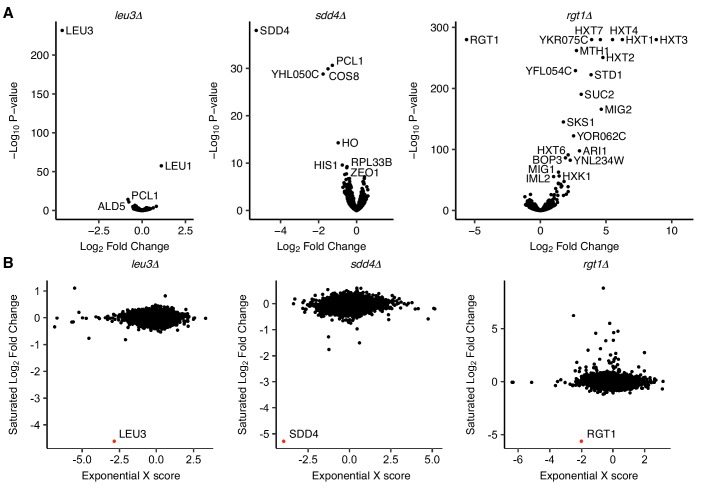
Transcriptional effects of TF deletion in saturated culture and exponential growth.(A) Volcano plots of differentially expressed genes in TF deletion strains compared to a wild-type control in saturated culture conditions, by RNA-seq. (B) Comparison of log2 fold change from RNA-seq in saturated culture conditions to gene expression microarray ‘X scores’ (normalized, confidence-weighted log ratios) in exponential growth (Hu et al., 2007), with deleted gene highlighted in red.